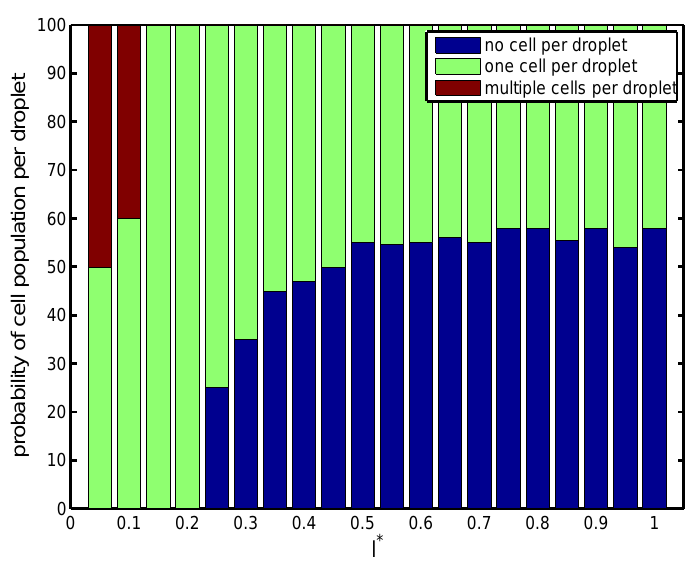
Figure 6. Probability of cell population per droplet (%) for configurations with different non-dimensional orifice lengths at Ca i = Ca o = 10 − 3 . Other geometrical parameters are kept fixed ( r ∗ = 0.25 and d ∗ =